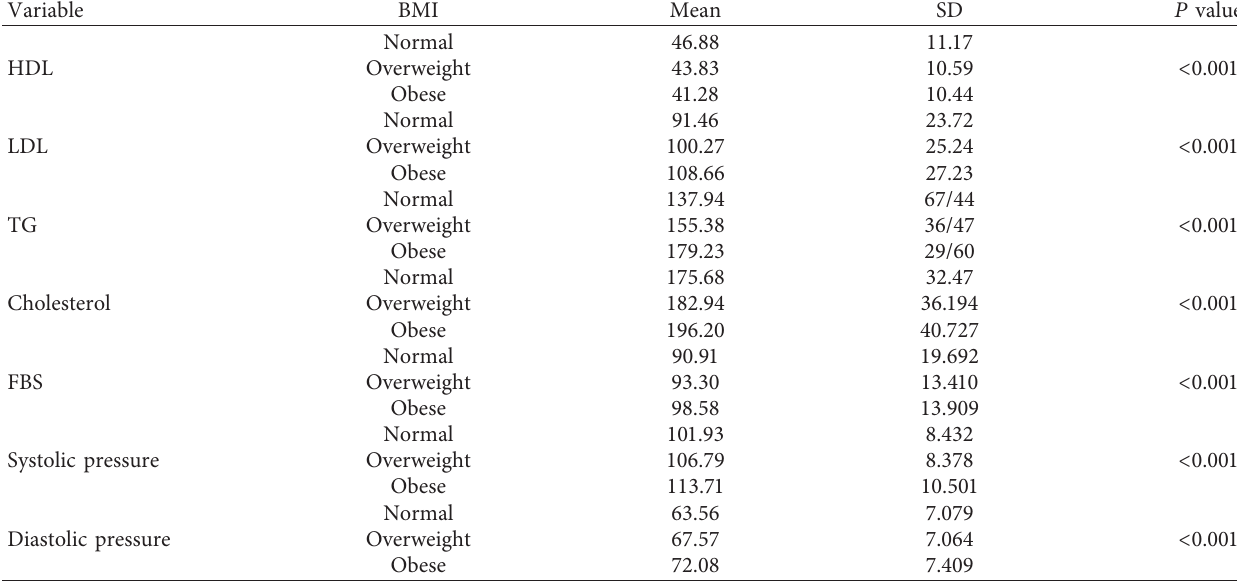
Table 4: The relationship between clinical and laboratory cardiovascular risk factors and BMI.